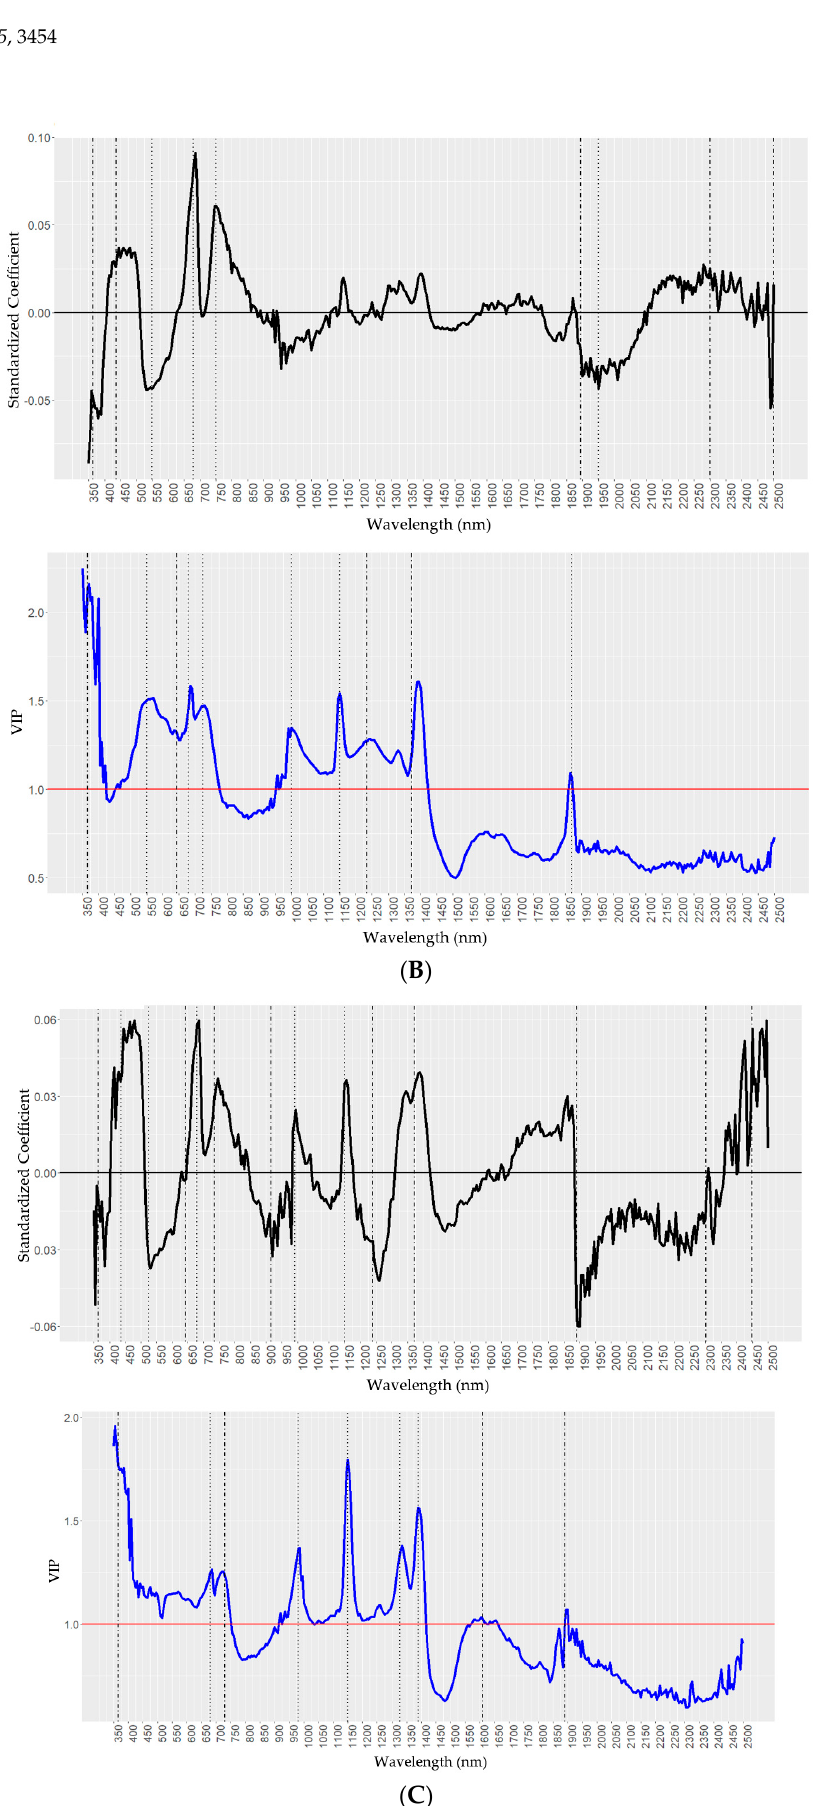
Figure 4. Qualitative parameters variable importance of projection (VIP, blue line) and standardized coefficients (black line) for fatty alcohols. ( A ) Hentriacontanone-16 (H16), ( B ) Octacosanol-1 (Oct), and